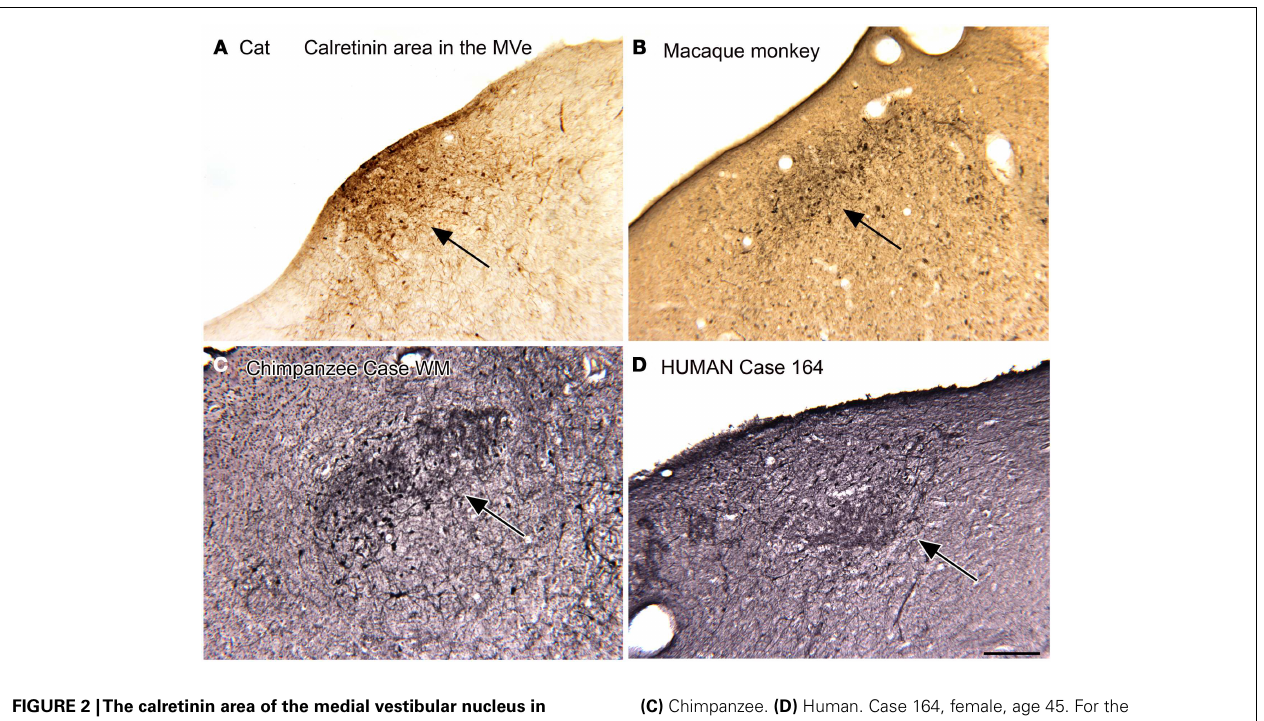
FIGURE 2 |The calretinin area of the medial vestibular nucleus in four species . In each panel, the arrow indicates the region of calretinin-immunoreactive cells and processes. (A) Cat. (B) Macaque monkey. (A,B) Immunoreactivity was visualized by the DAB method.